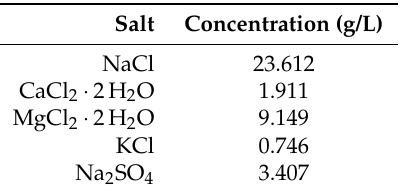
Table 2. Composition of synthetic seawater